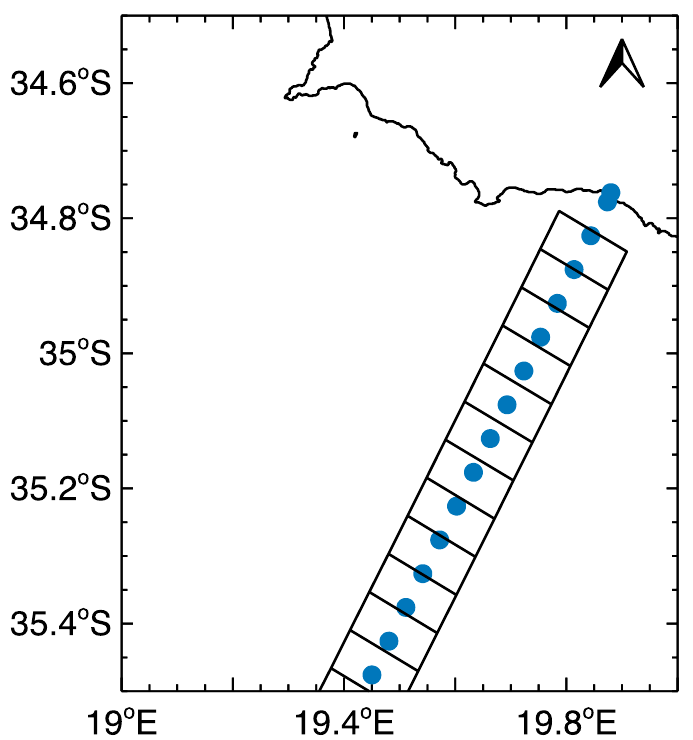
Figure 2. Altimeter track 031 along the southwest corner of South Africa, showing the locations of the nominal grid points that define the altimeter track (not data points) and the coastal crossing (blue dots). The rectangular areas within which L2B scatterometer wind speed retrievals are binned extend 6.5 km on either side of the track and 7 km along the track, starting 7 km from the coastal crossing. The box that would be touching the coastal crossing is not shown or used.